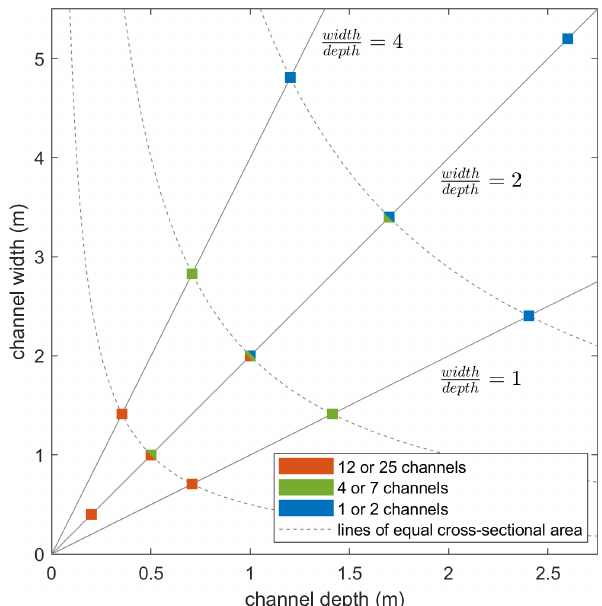
Figure 7. Channel width (m) and depth (m) for the different channel dimension scenarios. For each value for the number of channels, five possible channel dimension scenarios are